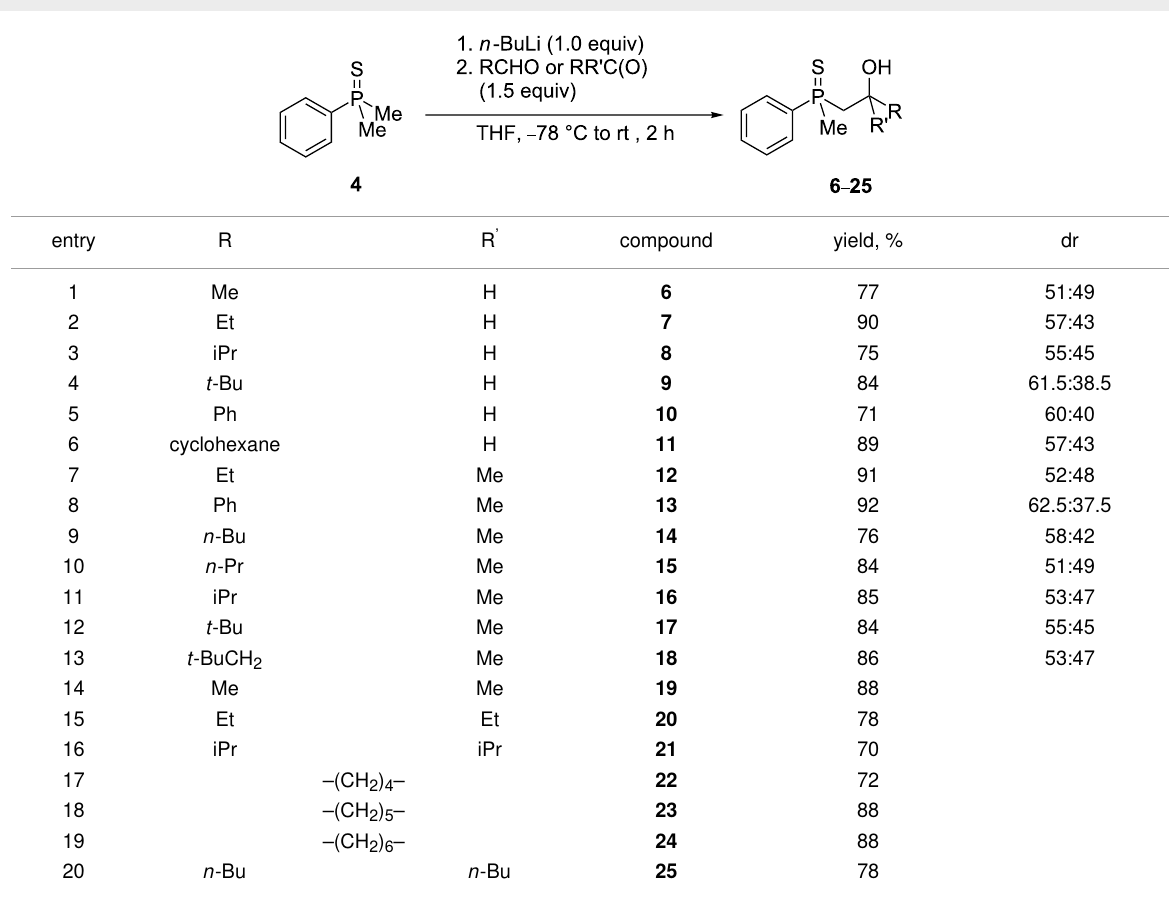
Table 1: Synthesis of substrates for this study.